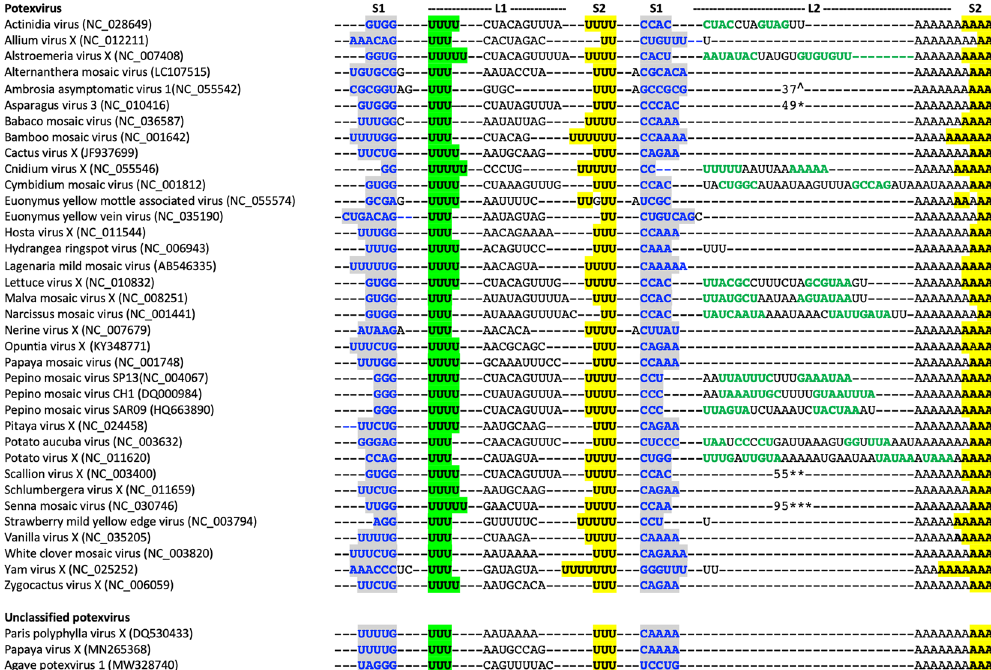
Figure 2. Alignment of 3 ′ -ends of potexviruses capable of forming a pseudoknot structure. Bases in blue font form stem S1, those highlighted in yellow form stem S2. The 5 ′ -proximal U-rich motif is highlighted in green. Putative hairpins formed by bases in L2 are shown in green font. * AGC AGA CUA UCA UAU UUA CUC UCU UUG AGC GUU AAU AAG UAC GUG UGU U insert in L2 of Asparagus virus 3. **AUC AGA CUC UCC AUC CUA